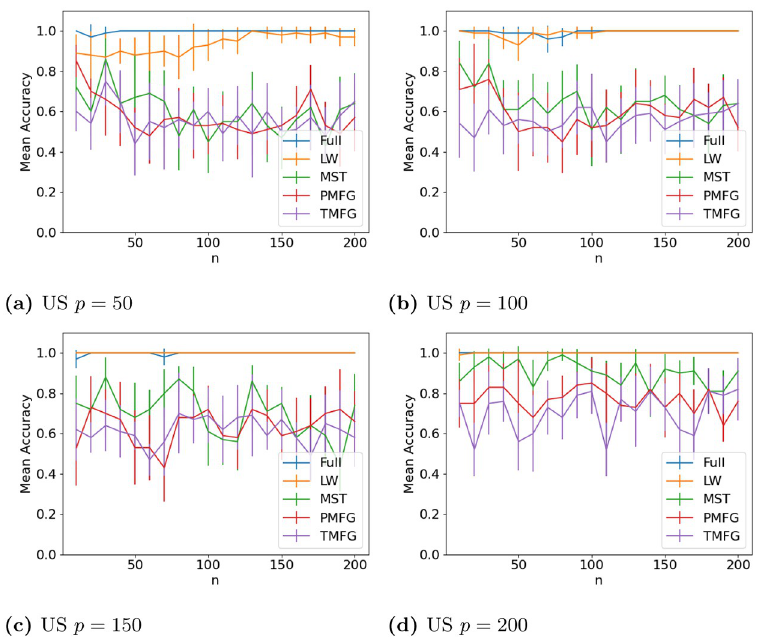
Fig 10. Accuracy when distinguishing between correlation matrices created from the stock windows with the maximum and minimum volatility using the SF method and a random forest classifier with US stock returns. (a) US p = 50, (b) US p = 100, (c) US p = 150, (d) US p = 200.